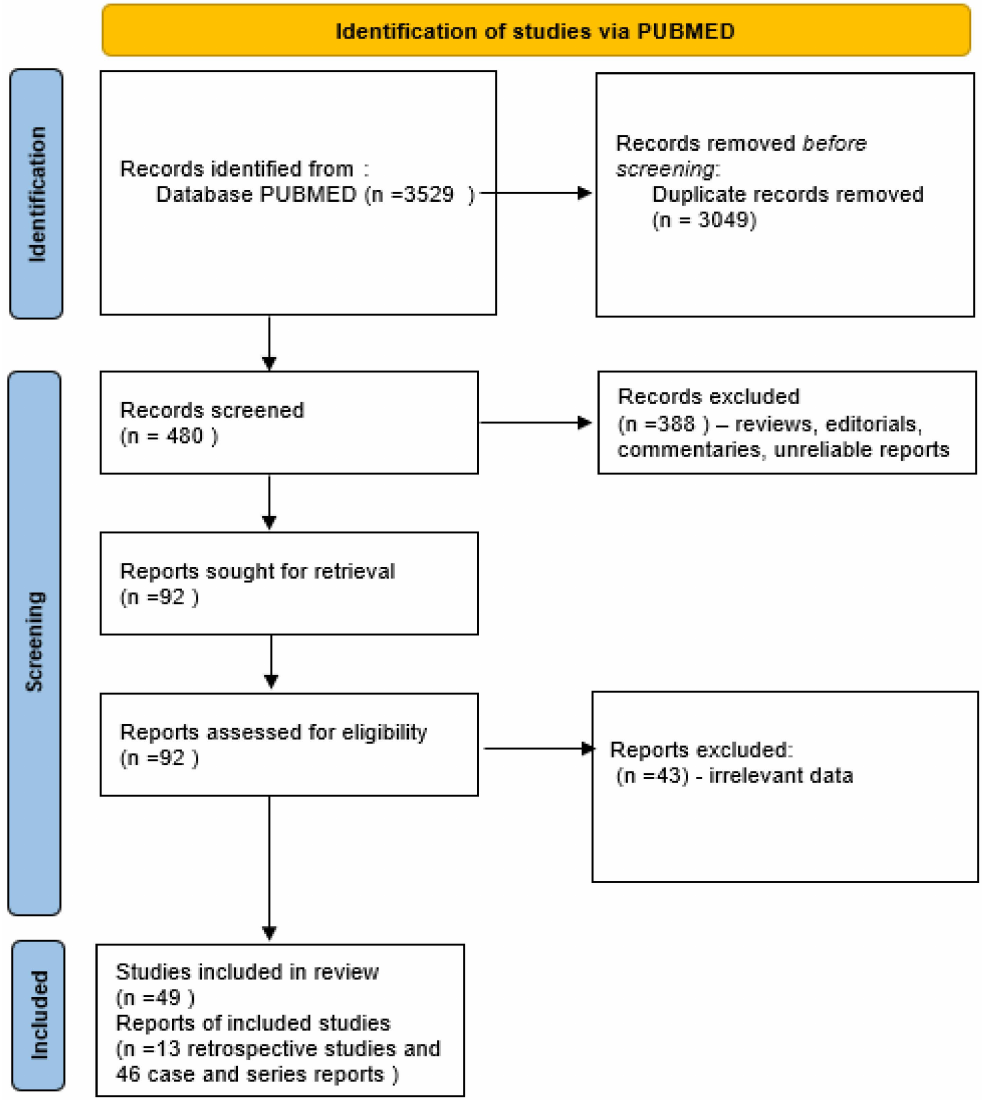
Figure 1. Flow chart of the systematic literature search according to PRISMA guidelines. A total of 3529 articles were found during the initial screen and 49 articles were included in the qualitative